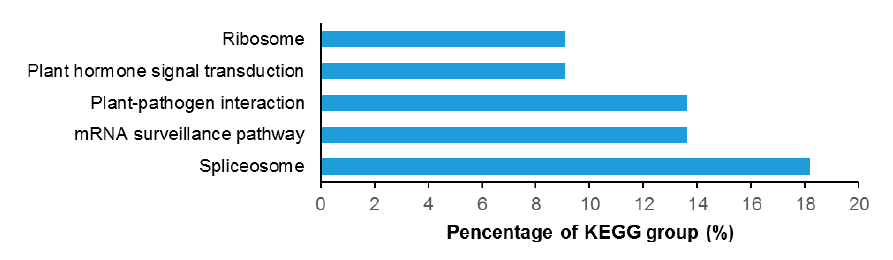
Figure 5. The top five KEGG pathways in the differentially-phosphorylated phosphoproteins in A. mongolicus roots under drought stress.